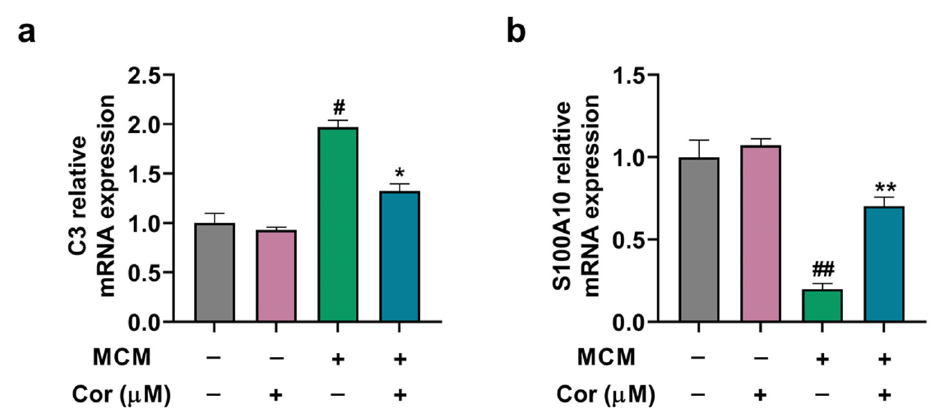
Figure 8. Cornuside regulated A1/A2 phenotypic switch of C6 cells induced by MCM. ( a ) C3 mRNA level and ( b ) S100A10 mRNA level in C6 cells were detected in response to the microglia-conditioned medium or control medium. GAPDH was used as the control. Data are all expressed as mean ± SEM from quadruplicate experiments ( n = 4 per group). # p < 0.05 and ## p < 0.01 compared with MCM (-)/Cor (-); * p < 0.05 and ** p < 0.01 compared with MCM (+)/Cor (-).